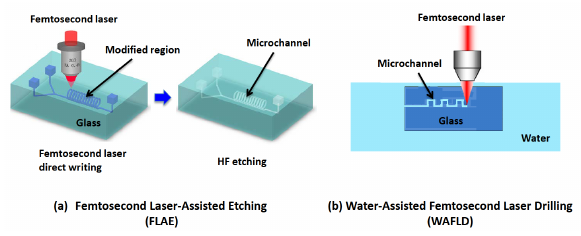
Figure 12: Schematic illustrations of two methods available for the fabrication of 3D microfluidics structures by ultrafast laser process- ing: (a) femtosecond laser-assisted etching (FLAE) and (b) water- assisted femtosecond laser drilling